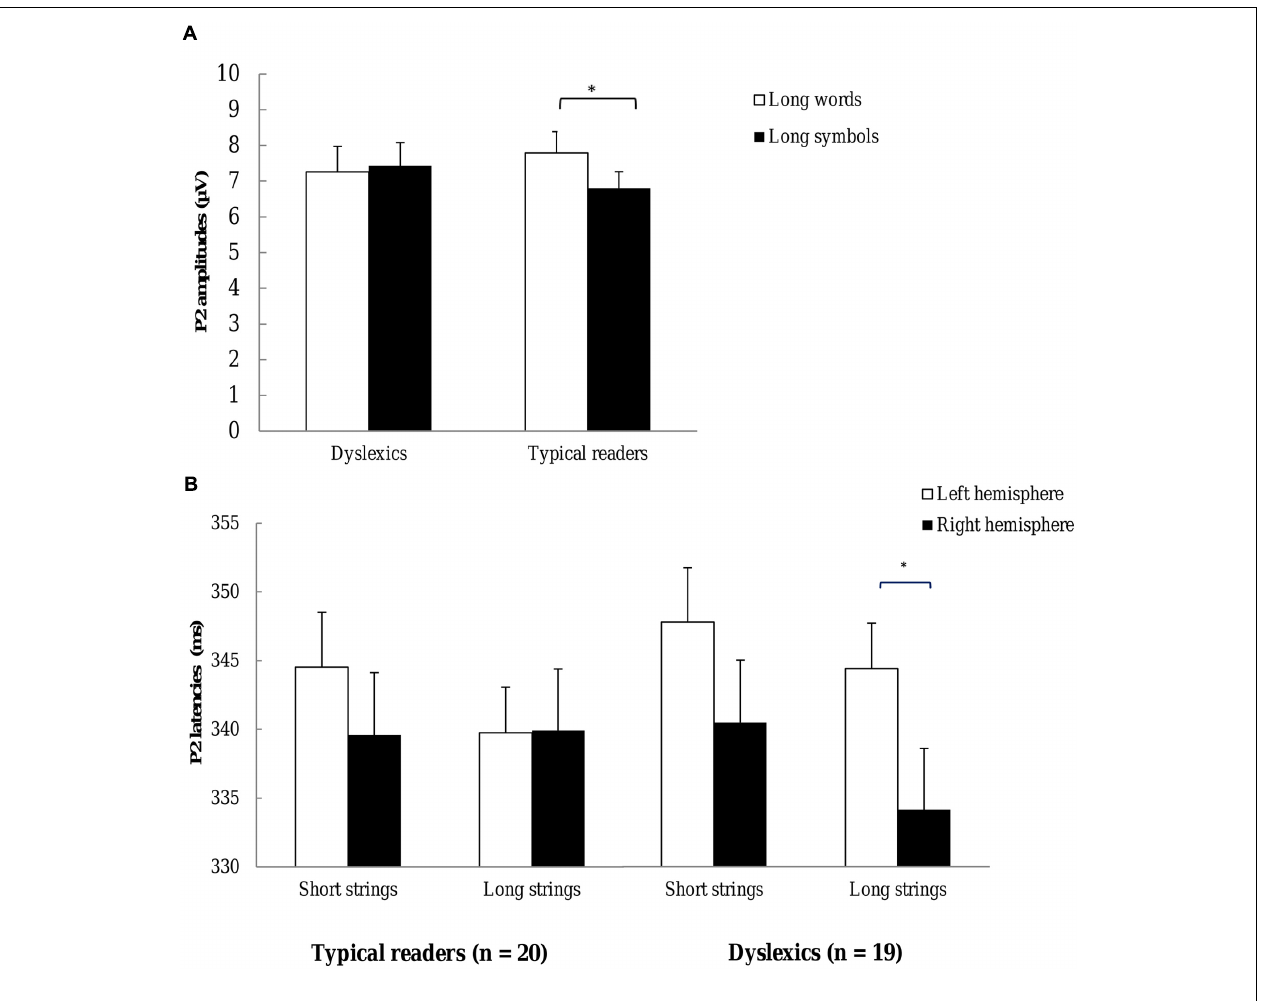
FIGURE 7 | P2 (A) P2 amplitudes for each group. Open bars refer to the P2 amplitudes to words and filled bars to the P2 amplitudes to symbol strings. Plots represent P2 amplitudes to long strings. P2 amplitudes are averaged acrossTP7,TP8, P9, P10, P7, P8, P5, P6, PO7, PO8, PO3, PO4, O1, and O2